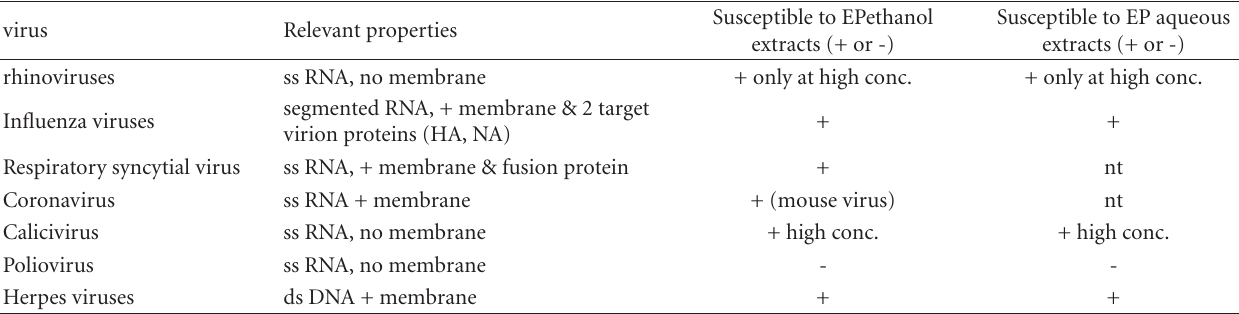
Table 2: Antiviral activities of EP at noncytotoxic